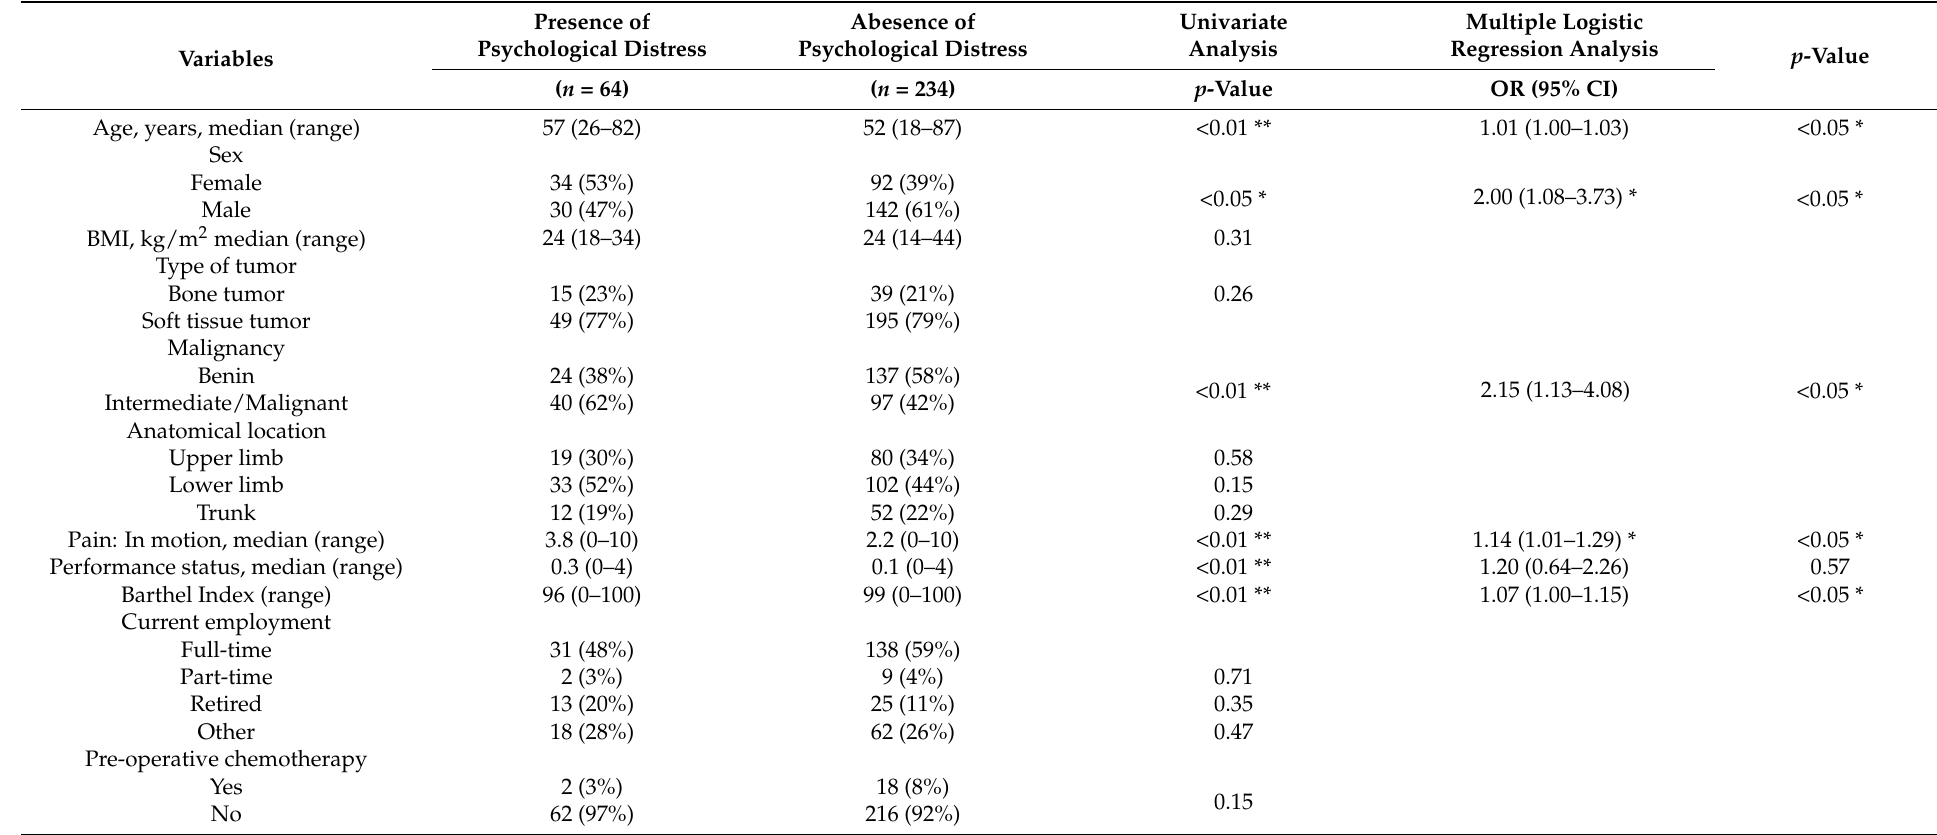
Table 4. Univariate and multivariable logistic regression of risk factors related to psychological distress in all